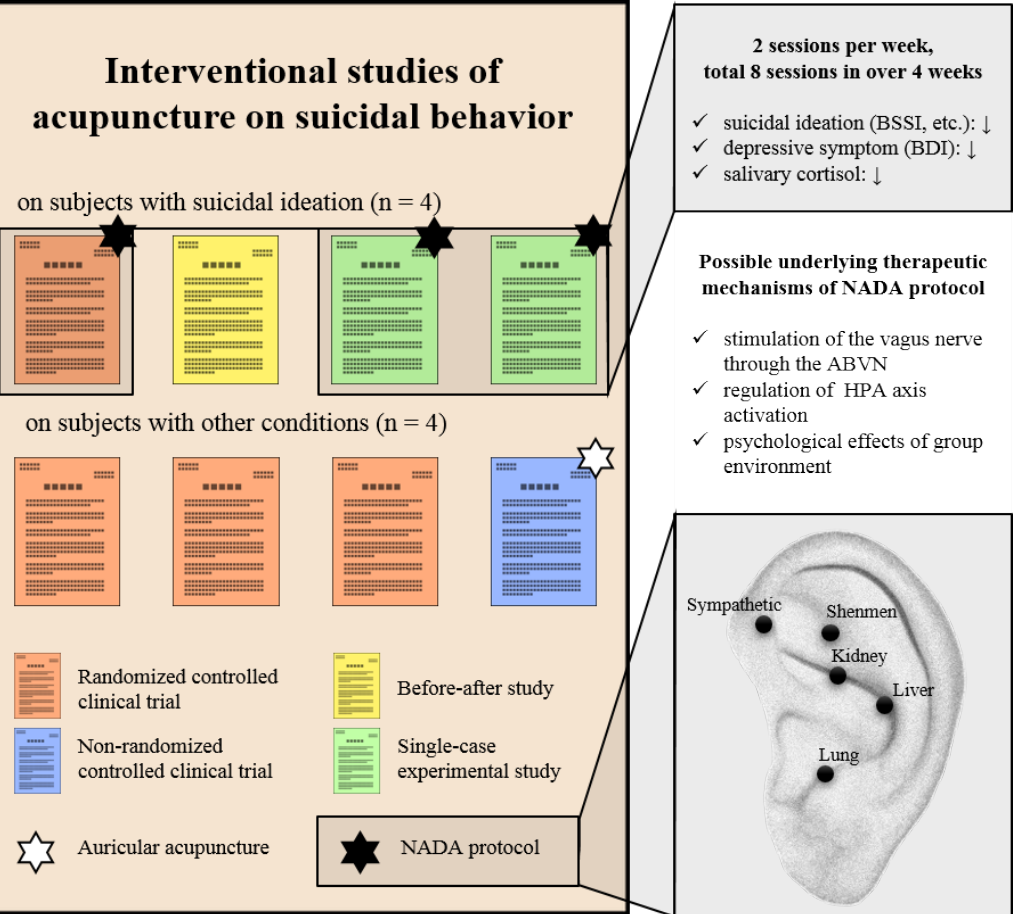
Figure 2. Summary of findings from this review and NADA protocol. Abbreviations. ABVN, the auricular branches of the vagus nerve; BDI, Beck Depression Inventory; BSSI, Beck Scale for Suicidal Ideation; HPA axis, hypothalamic – pituitary – adrenal axis; NADA, the National Acupuncture Detoxification Association. The down arrow sign means decrease.